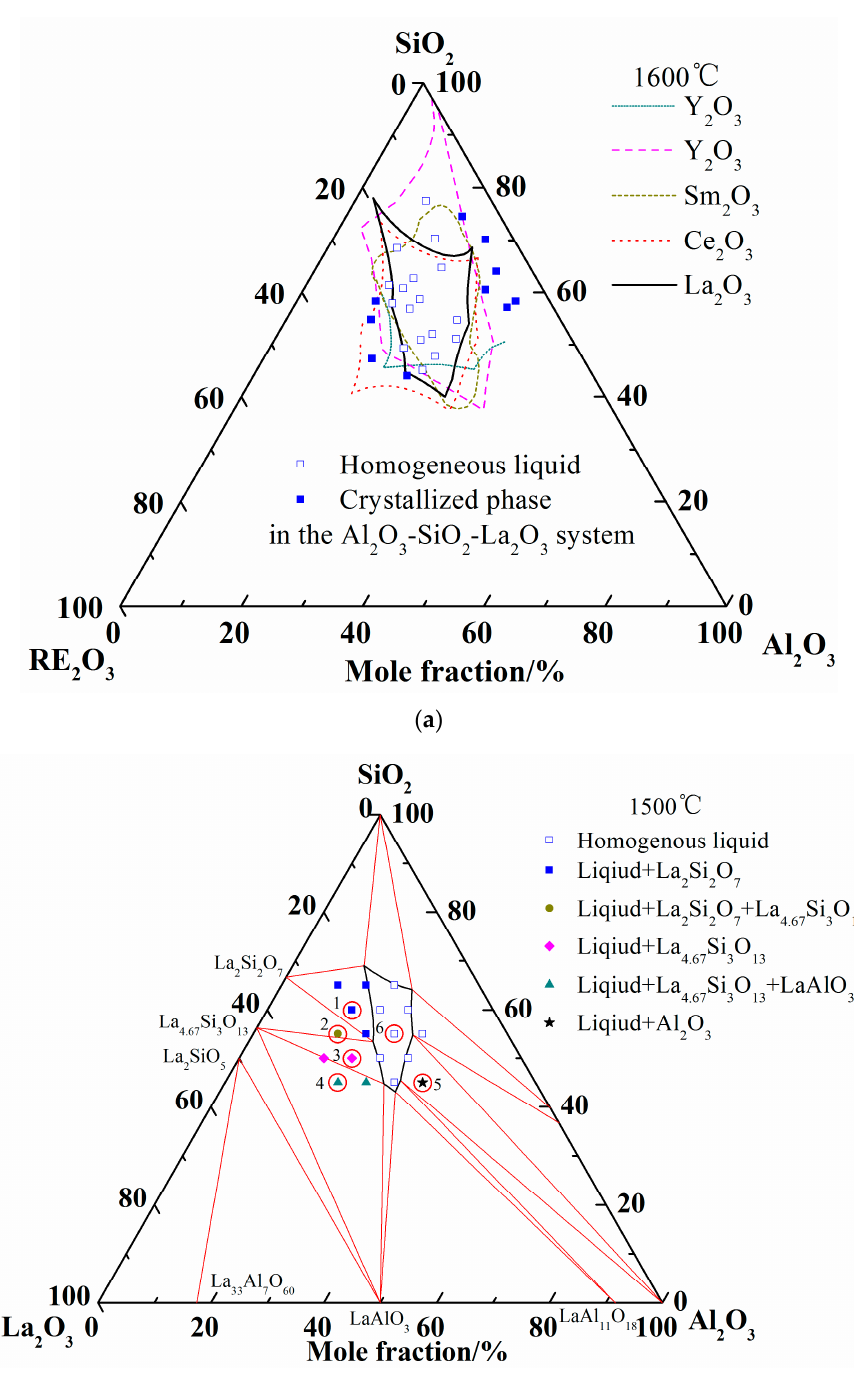
Figure 4. Comparison of liquid region of ternary phase diagrams. ( a ) Liquid regions of ternary phase diagrams at 1600 ℃ ; ( b ) Liquid region and experimental points at 1500 ℃ .